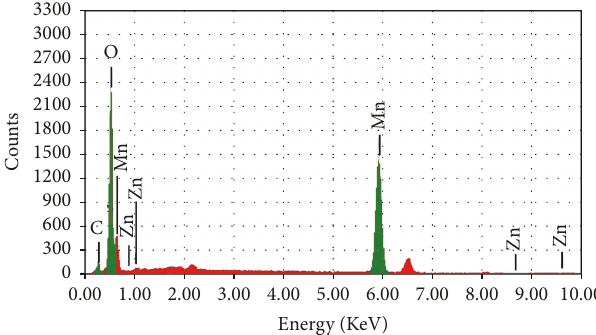
Figure 2: EDX analysis of the as-synthesized catalysts calcined 1% ZnO –MnCO 3 . x